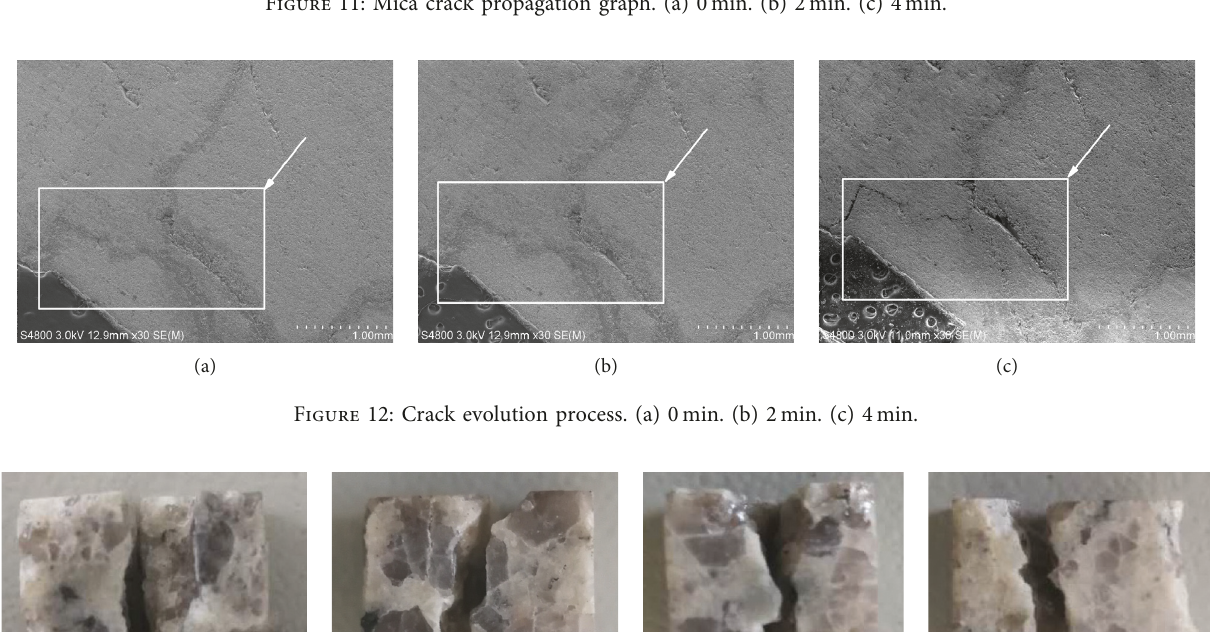
Figure 11: Mica crack propagation graph. (a) 0min. (b) 2min. (c) 4min.